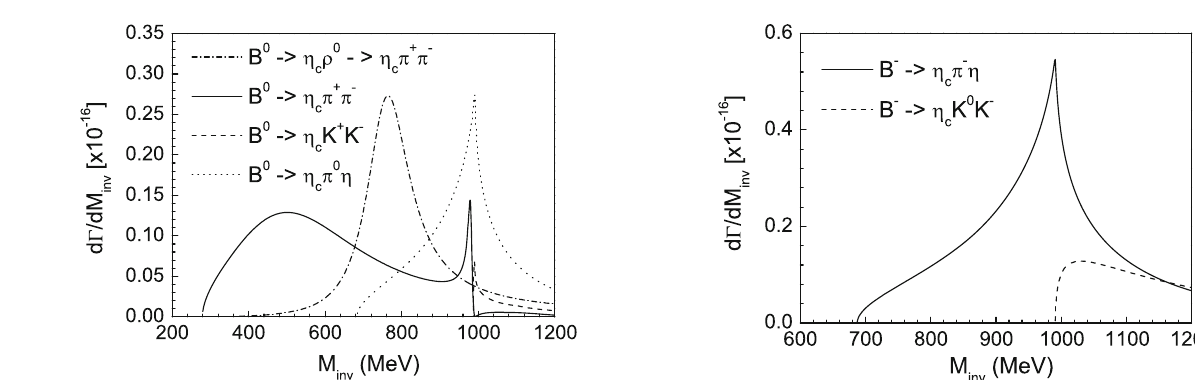
Fig. 5 π − η and K 0 K − invariant massdistributions for B − → η c π − η and B − → η c K 0 K